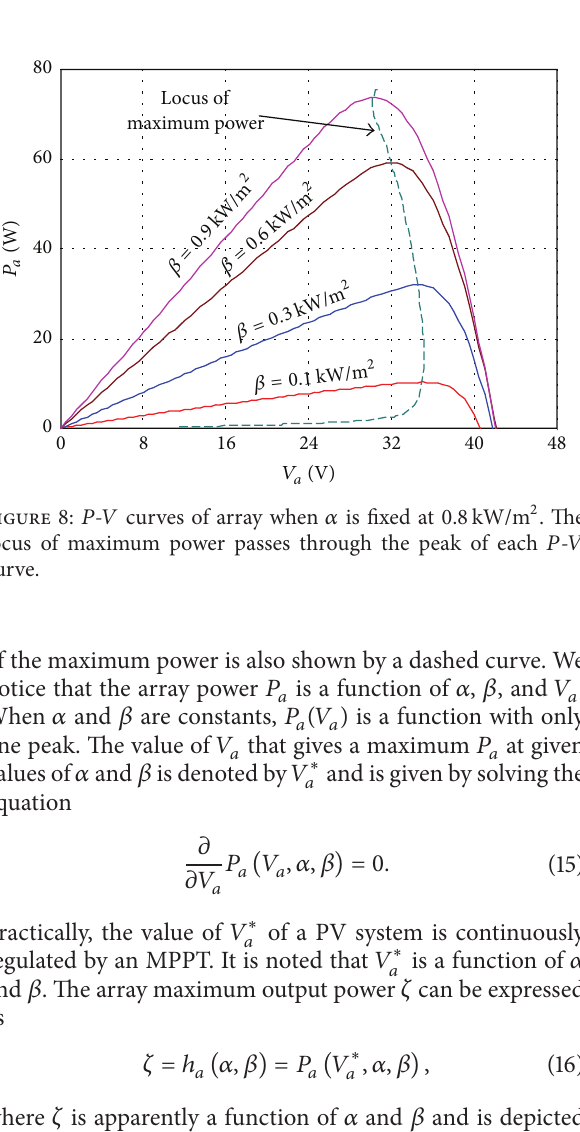
Figure 7: Equivalent circuit of an array composed of two series PV modules.